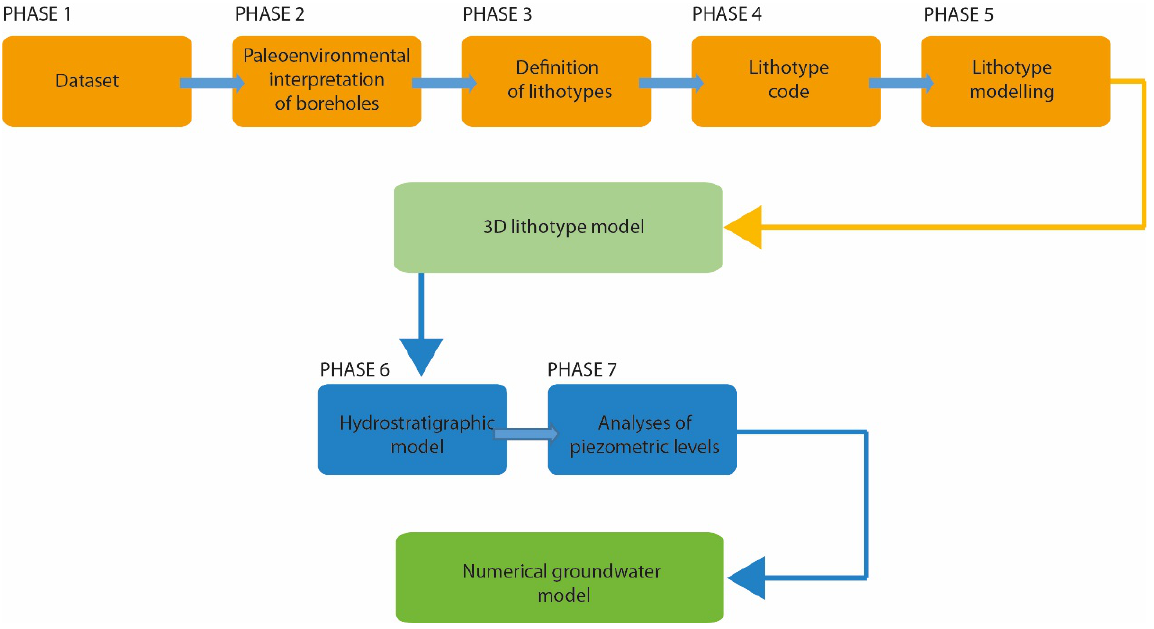
Figure 4. Workflow showing the phases of the 3D lithotype model development.